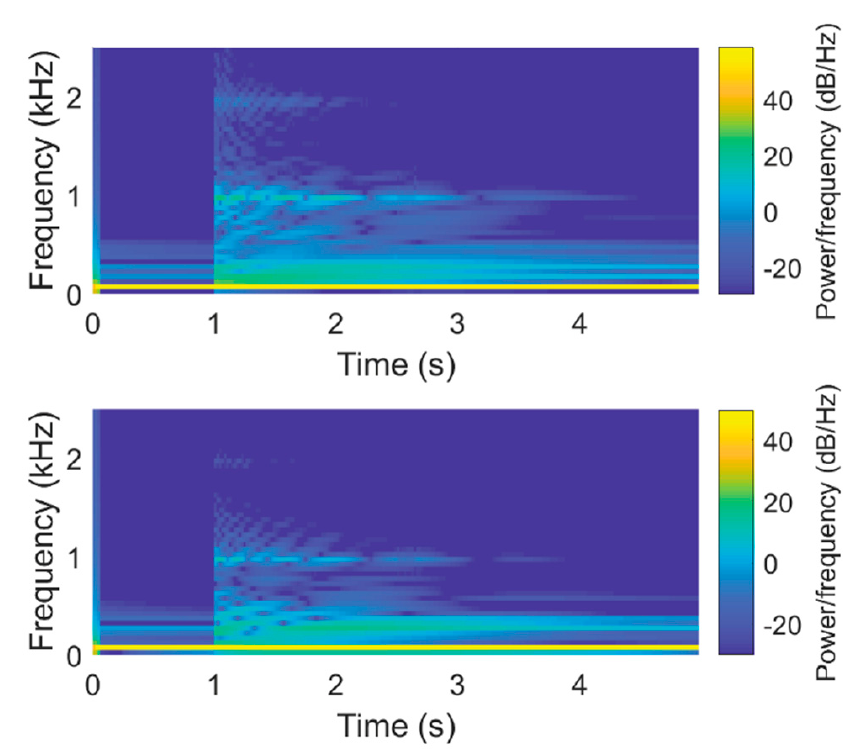
Figure 3. Spectrogram showing the spectral content at di ff erent time instances. Trf1 was switched on at 1 s while Trf2 was still in service .